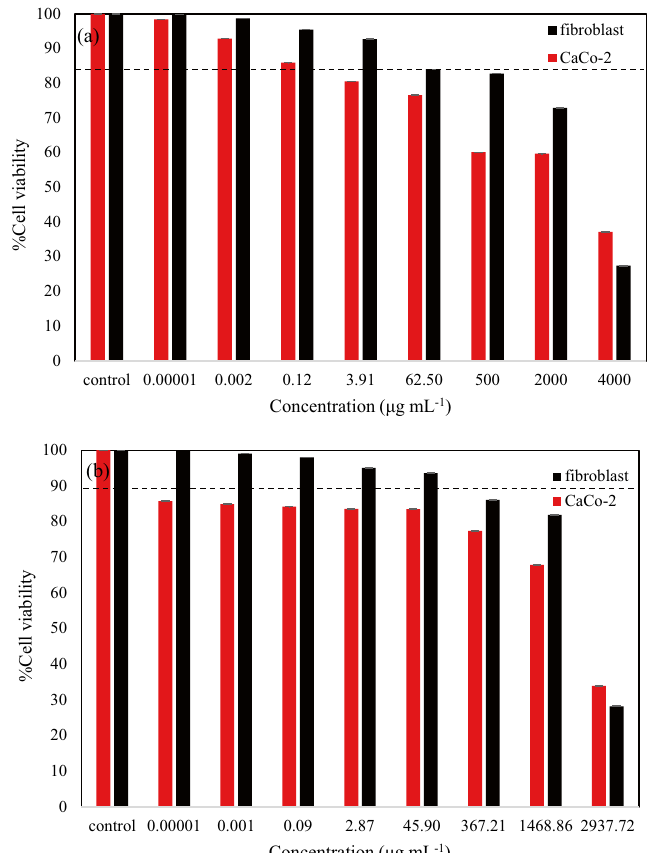
Figure 7. Cytotoxicity of fibroblast and CaCo-2 cells for 24 h incubation at different concentrations of ( a ) CDs- PEG, ( b ) CDs-PEG-DOX from 0.1–0.2 ng mL −1 to 2.9–4.0 mg mL −1